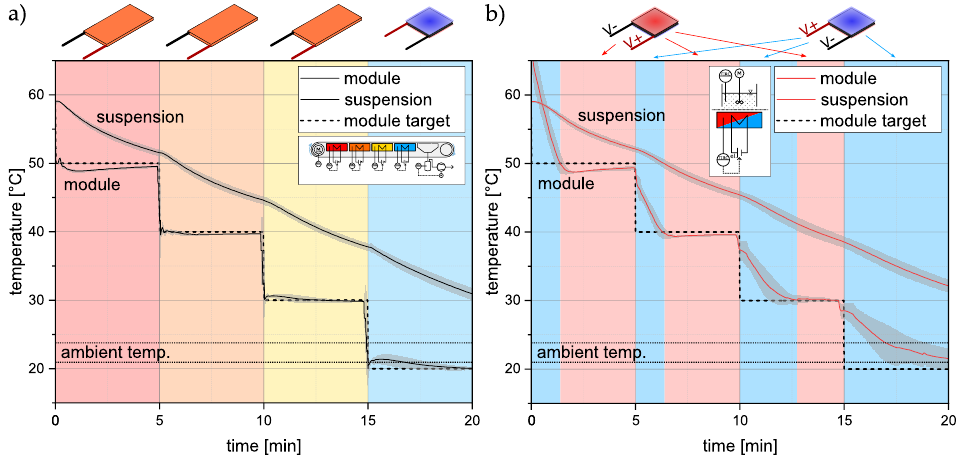
Figure 3. Different temperature approaches of the two setups. The control of the mini-plant is carried out with heating mats and an incrementally moving container that passes four temperature modules of constant temperature ( a ). In ( b ), a representation of the control with the help of Peltier elements in a single module can be found. Each of the experiments was performed in a fourfold manner. The standard deviations are